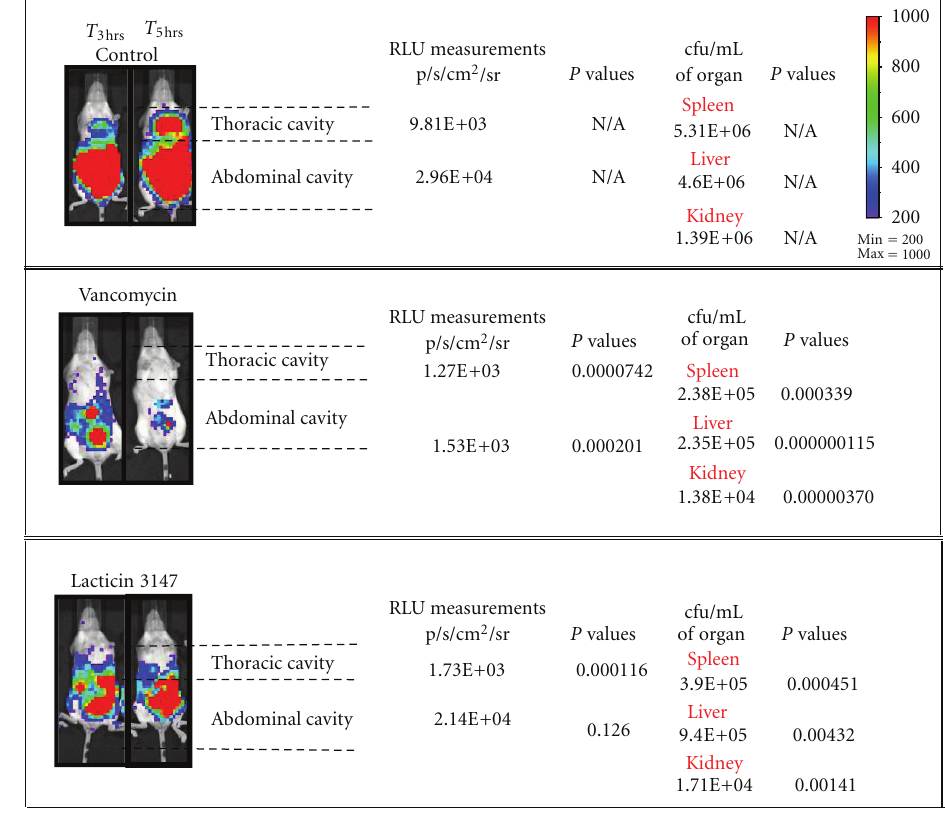
Figure 1: Impact of lacticin 3147 on the systemic spread of S. aureus Xen 29 in mice. Images are of representative mice from each group 3 and 5 hours postinfection. Values (i.e., RLU measurements and cfu/mL of organs) represent averages of data collected at T 5hrs , and P values refer to the significance of di ff erences between the treated and untreated equivalents at T 5hrs as determined by one-way analysis of variance, followed by the Holm-Sidak posttest. The imaging system depicts false-color images representative of di ff erent levels of total flux. False color imaging represents intense luminescence in red, moderate luminescence in green, and low level luminescence in